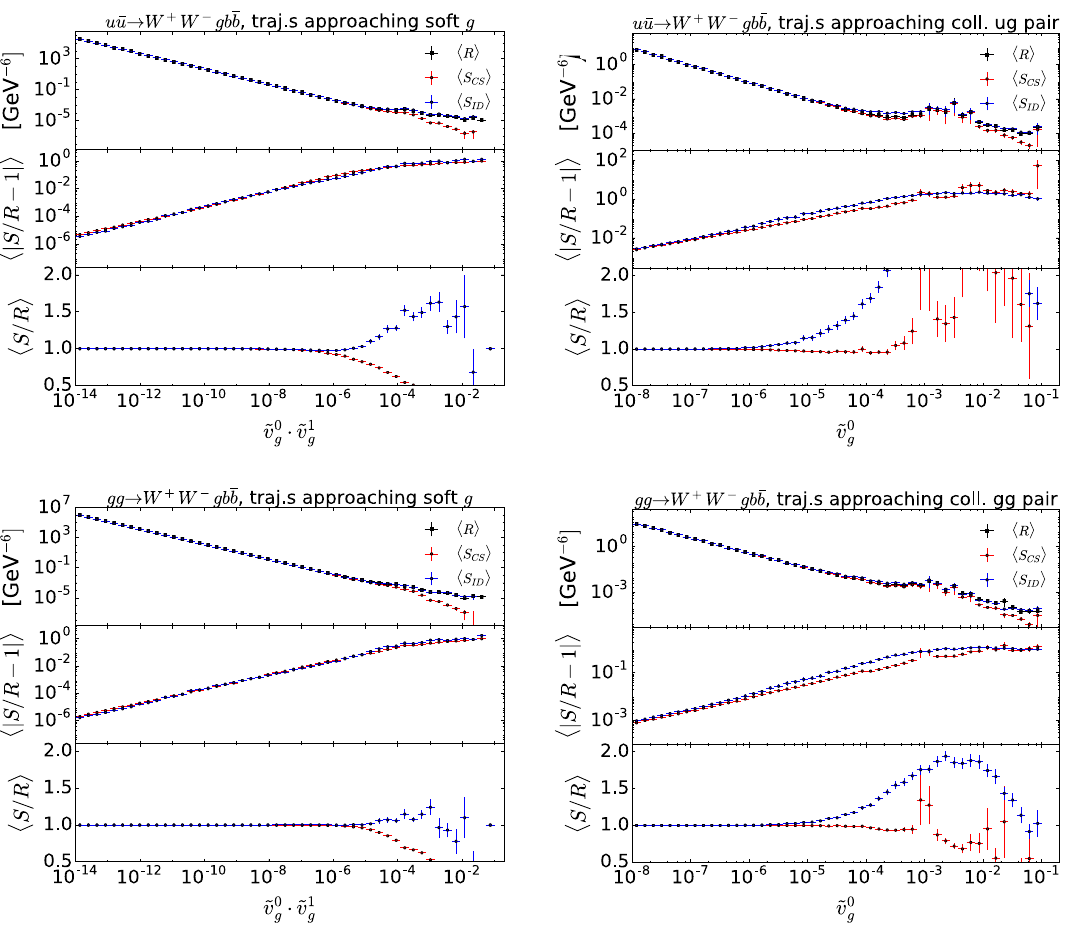
Fig. 8 Matrix elements R = | M R | 2 and sum of associated dipoles (cid:21) D (standard CS-dipoles in red, pseudo-dipoles in blue) for the S = processes u ¯ u → W + W − gb ¯ b (top) and gg → W + W − gb ¯ b (bottom). Bothdipole-typesareevaluatedonthesametrajectorieslikedescribedin